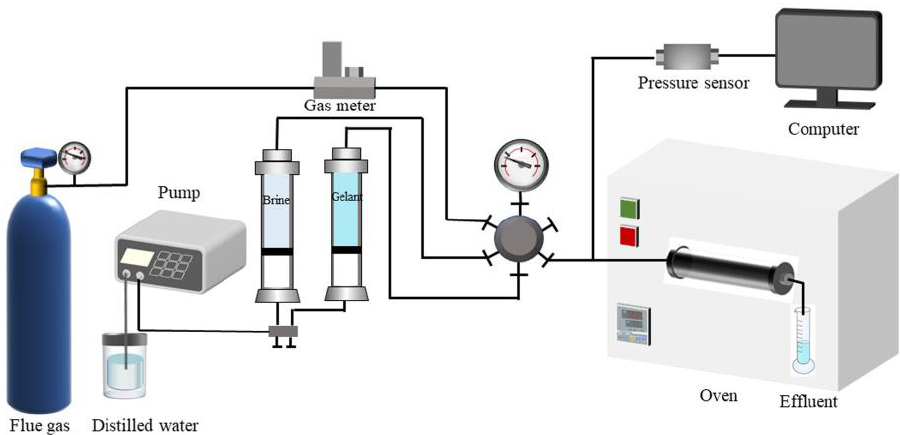
Figure 14. Schematic of equipment for investigating the plugging performance of